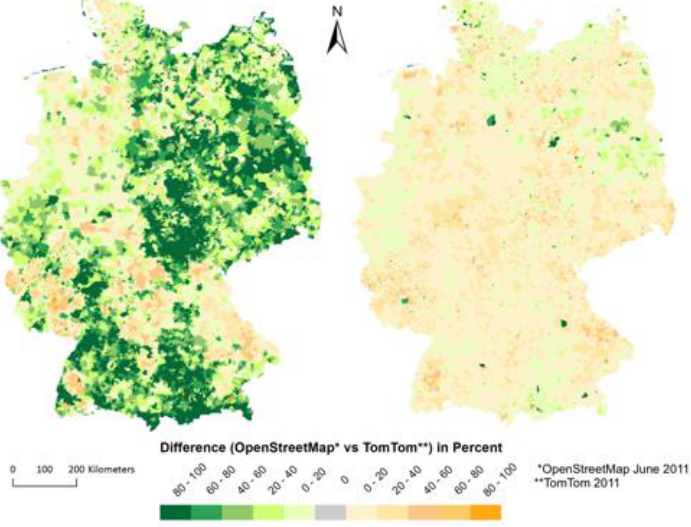
Figure 9. Relative Difference between TomTom and OSM for Total Route Network (left) and for Car Navigation Network (right) (June